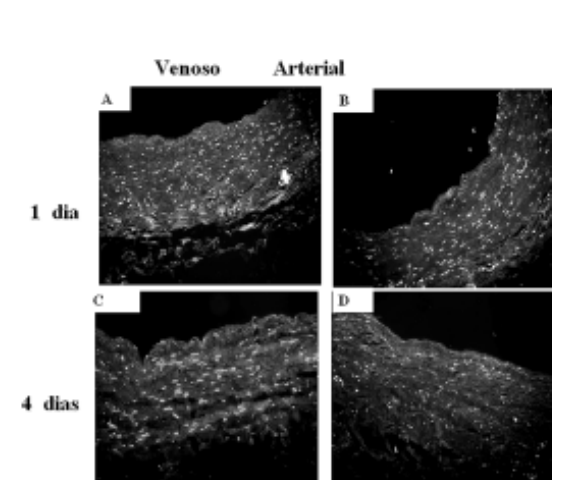
Fig. 4 - Coloração com Hoechst 33258 de veia safena cultivada por um (A,B) e quatro (C,D) dias, em regime hemodinâmico venoso (A,C) e arterial (B,D) (aumento de 100X).Observa-se manutenção da densidade celular nas veias safenas do grupo sob regime venoso (A,C), enquanto há diminuição dessa densidade no grupo sob regime arterial (B,D)